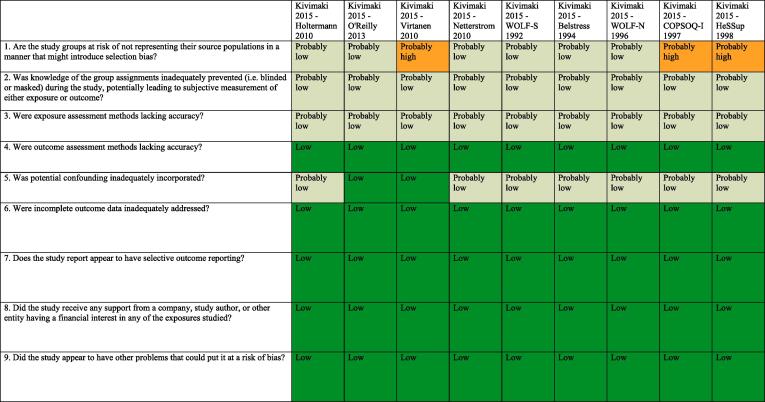
Summary of risk of bias, Died from ischaemic heart disease (IHD mortality).